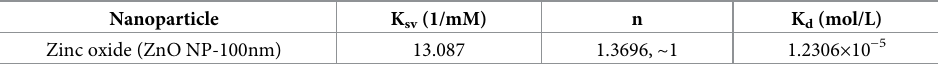
Table 2. Dissociation constant of RBD complexed to zinc oxide (ZnO NP-100nm).